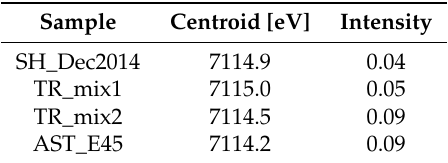
Table 2. XANES: pre-edge peak quantitative data analysis results on Saharan dust (SH_Dec2014), Steel production emission (AST_E45) and mixed aerosol samples collected in the Terni urban area (TR_mix1 and